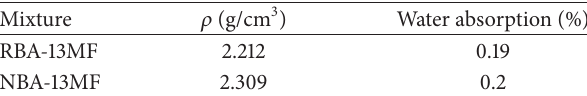
Table 8: Physical properties.